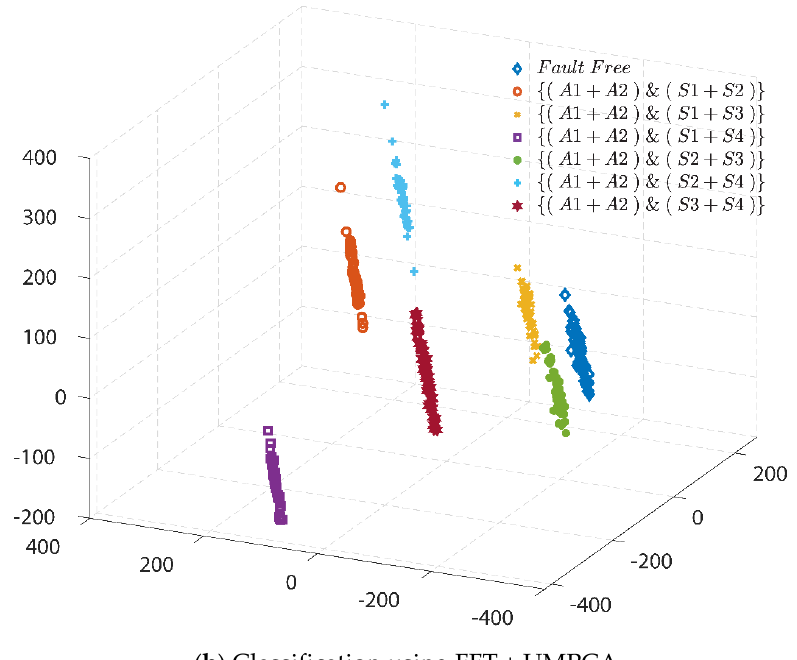
Figure 15. Three-dimensional space visualization performance for fault classification for wind turbines subjected to two actuator and two sensor faults under AWGN noises, using ( a ) FFT + MPCA and ( b ) FFT + UMPCA, respectively.